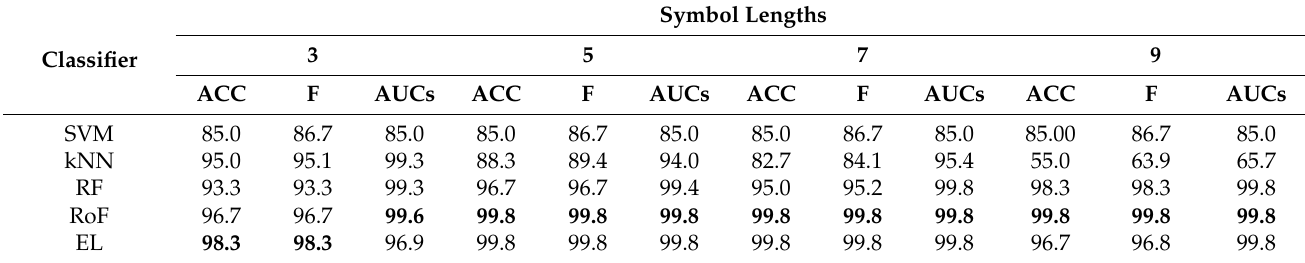
Table 7. The average F (%) and AUC (%) obtained by the DSA method for cross-dataset using W = 3. The PAF and SR segments are obtained from AFTDB and AFPDB databases, respectively. Bold values indicate the best performance in a